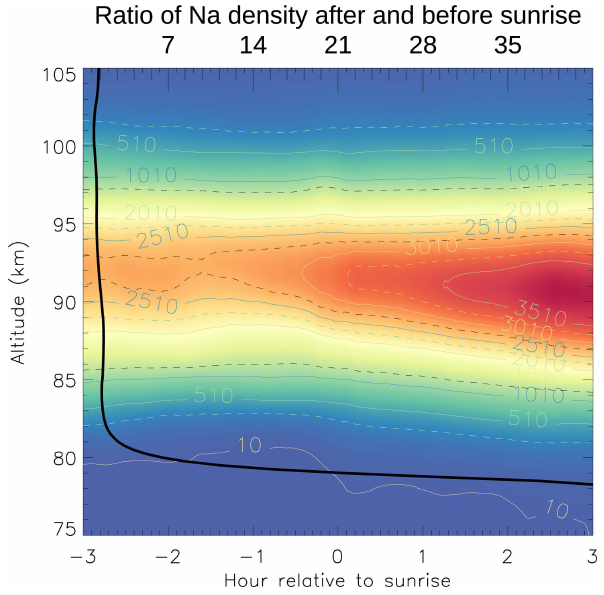
Figure 1. The Na density (cm − 3 ) variation between 75 and 105km in MLT during sunrise between 20 August and 30 September (con- tour) in 2011–2016. Zero hour marks time of the sunrise at the mesopause (bottom abscissa). The solid black profile is the ratio between the Na density 3h after sunrise to that 3h before sunrise (its tick marks is plotted in the top